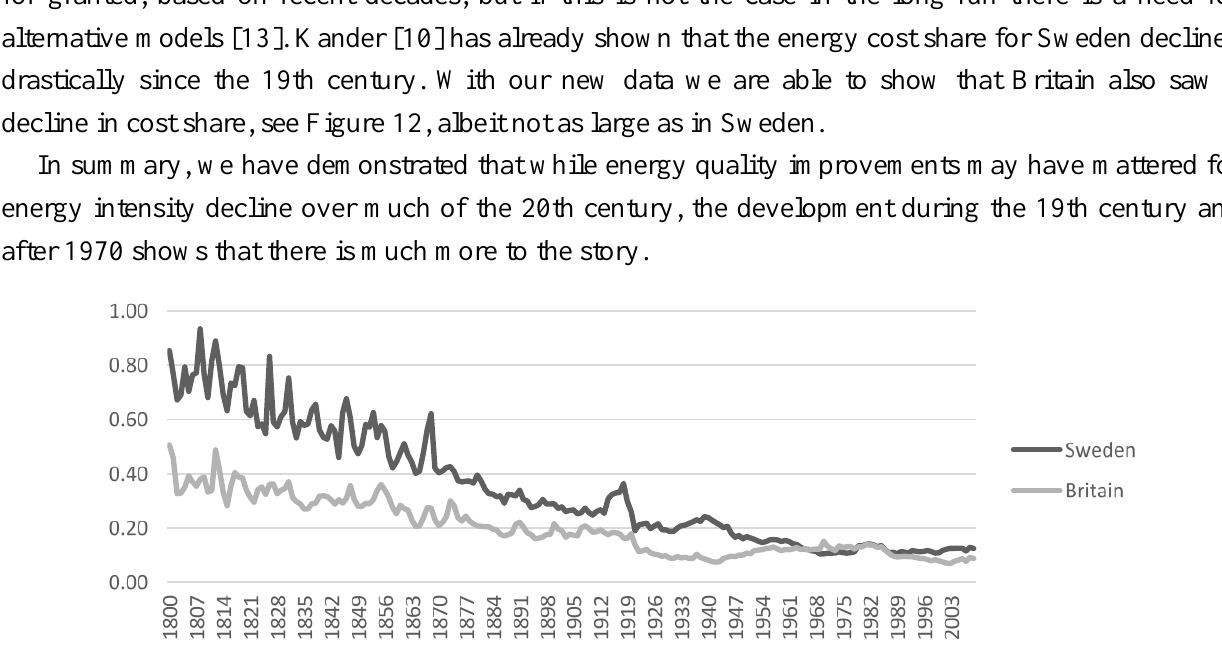
Figure 12. Energy cost share to GDP in Sweden and Britain, nominal